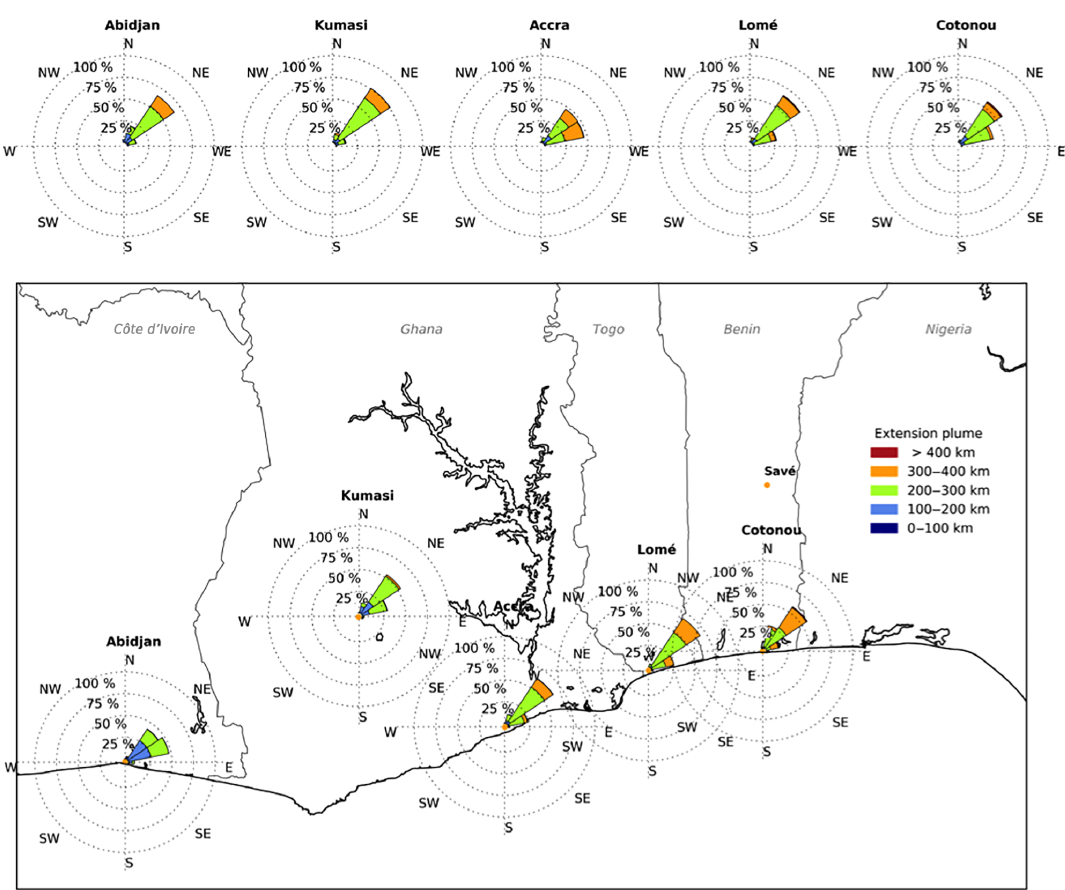
Figure 20. Pollution roses of urban plumes from the five main cities of interest during DACCIWA (Abidjan, Kumasi, Accra, Lomé, Cotonou) during Phase 2 (22 June–20 July 2016). Each rose shows the predominant direction of plumes and their horizontal extension (colour code). The radius values correspond to the percentage of pollution plume direction occurrence in each sector. Pollution roses derived from FLEX- PART simulations are superimposed on the map. HYSPLIT-derived pollution roses are at the top. See Sect. 2.2 for more